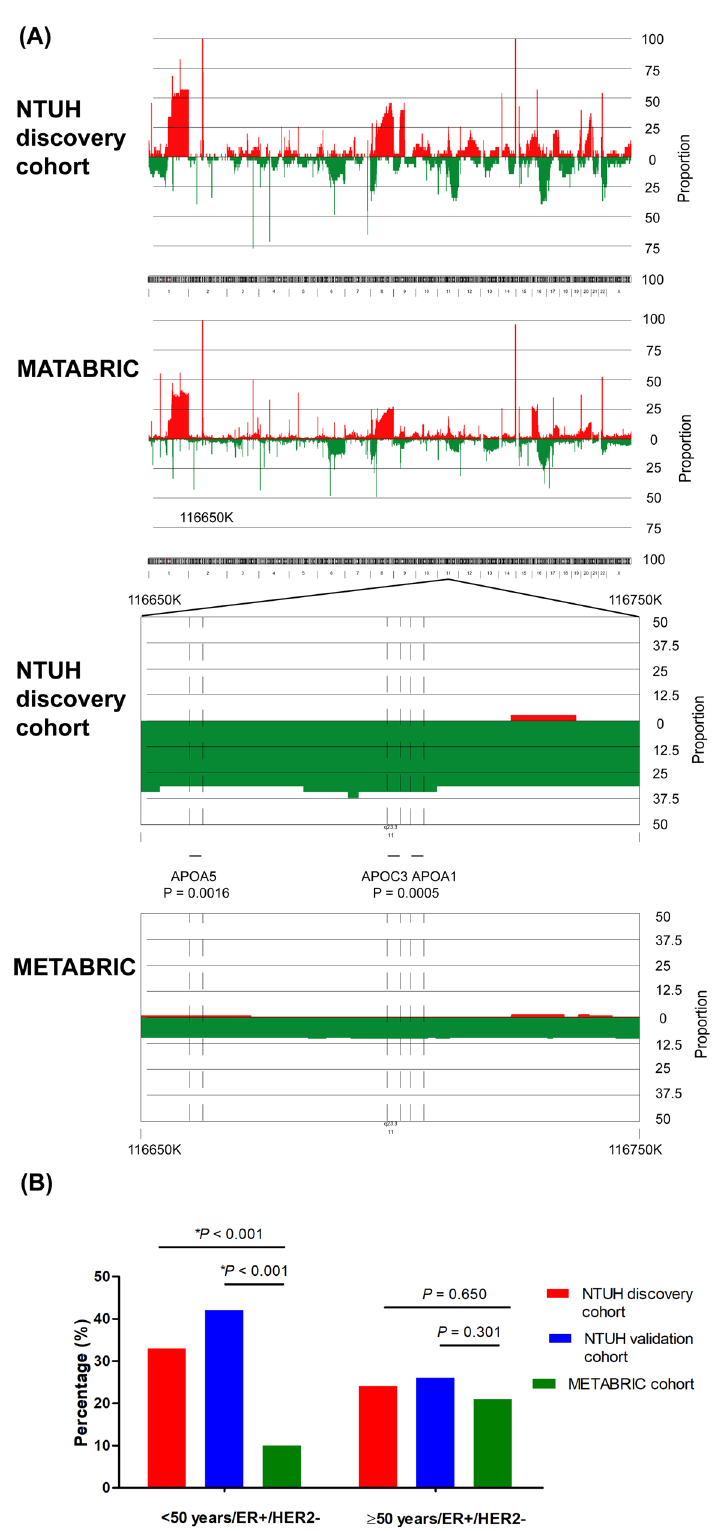
Fig. 2 CNV alterations of APOA1 , APOC3 , APOA4 , and APOA5 . CNV patterns ( A ) and frequencies of APOA1/C3/A4/A5 or APOC3/A5 copy number loss ( B ) of breast tumors in age <50 years/ER + /HER2- subgroup of East Asian (NTUH discovery cohort and/or NTUH validation cohort) and Western (METABRIC cohort)